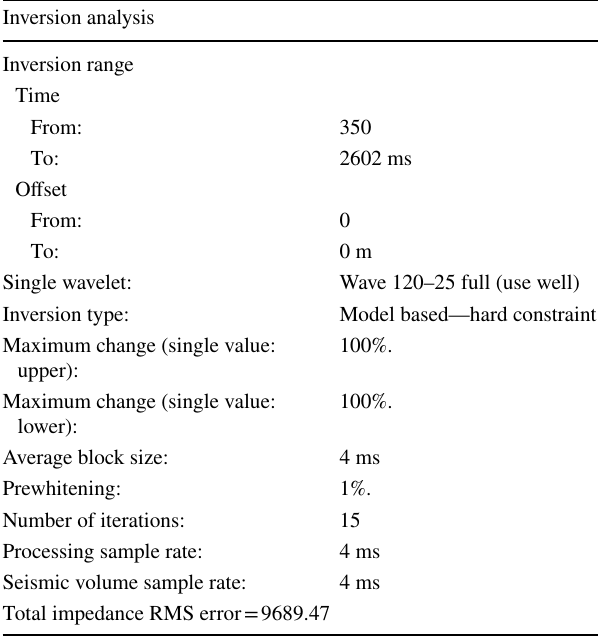
Table 1 The inversion parameters used to obtain the final acoustic impedance model Inversion analysis